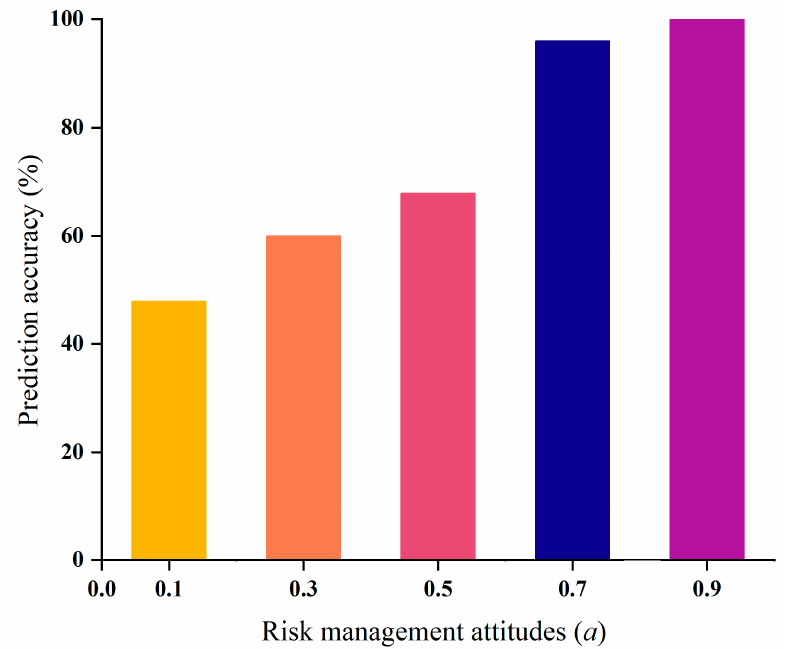
Figure 12. Prediction accuracy of different risk ‐ coping attitudes.